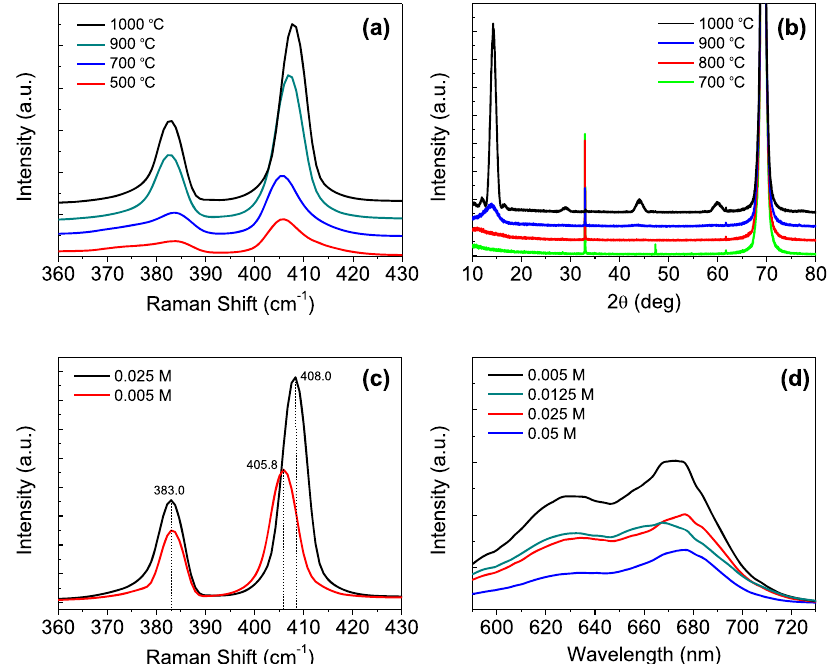
Fig. 2 Raman, XRD, and PL analyses. a Raman spectra and b XRD with annealing temperatures. c Raman spectra and d PL spectra with